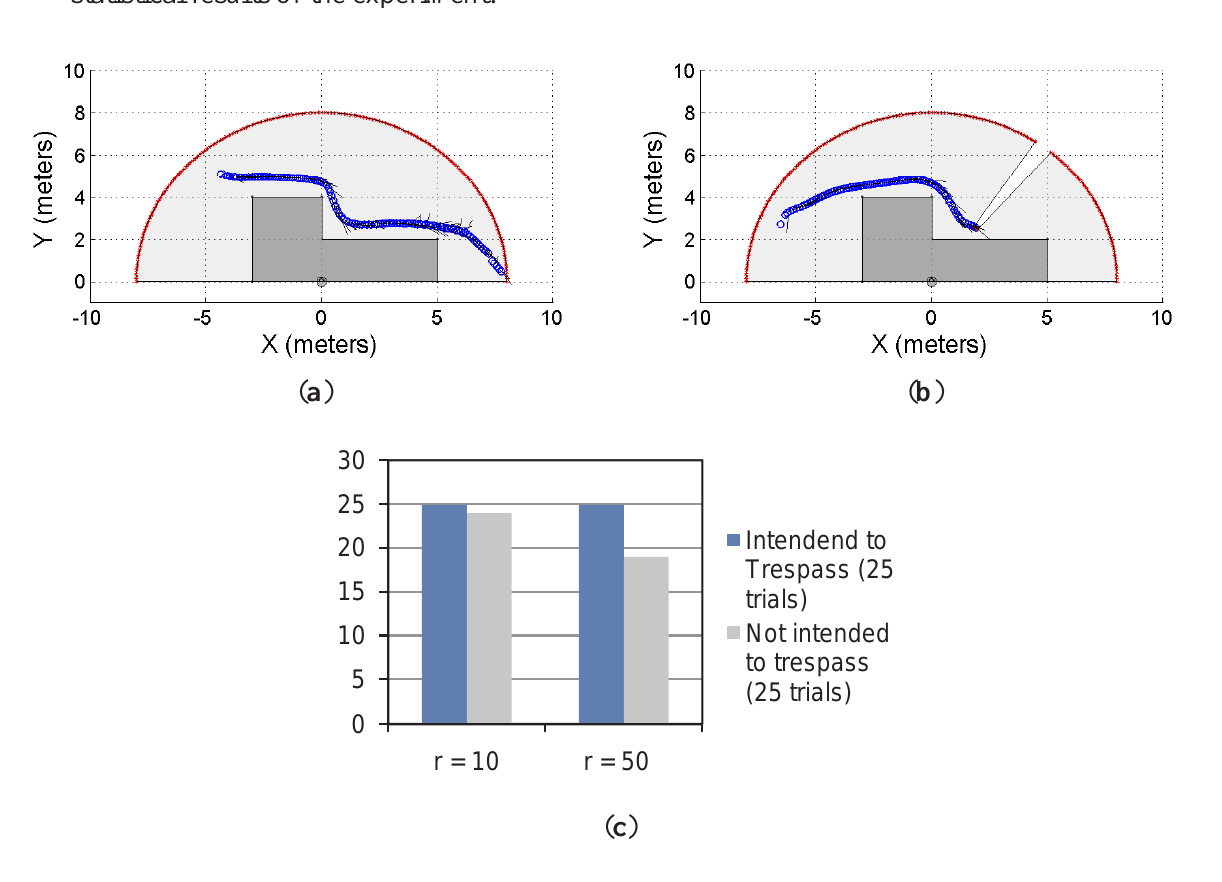
Figure 6. Single object prediction approach: second case. ( a , b ) two examples; ( c ) the statistical results of the